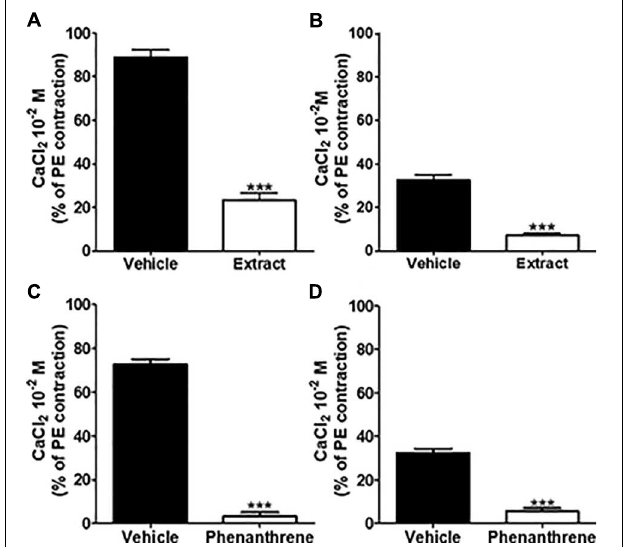
FIGURE 5 | Effect of EM extract or phenanthrene on extracellular Ca 2 + induced vasoconstriction. To study effect of EM extract or phenanthrene on extracellular Ca 2 + influx, the endothelium-denuded mesenteric rings were incubated in Ca 2 + -free Krebs solution, then pre-incubated with vehicle or EM extract at 125 µ g/ml or phenanthrene at 35 µ M for 10 min and contracted with either 10 − 5 M PE (A,C) or 8 × 10 − 2 M KCl (B,D) , and followed by the addition of 10 − 2 M CaCl 2 . Changes in tension are expressed as the percentage of the contraction to 10 − 5 M PE. Values are means ± SEM of n individual arteries. ∗∗∗ p < 0.001 vs. vehicle, ( n = 8–14). FIGURE 6 | Inhibitory effect of EM extract or phenanthrene on intracellular